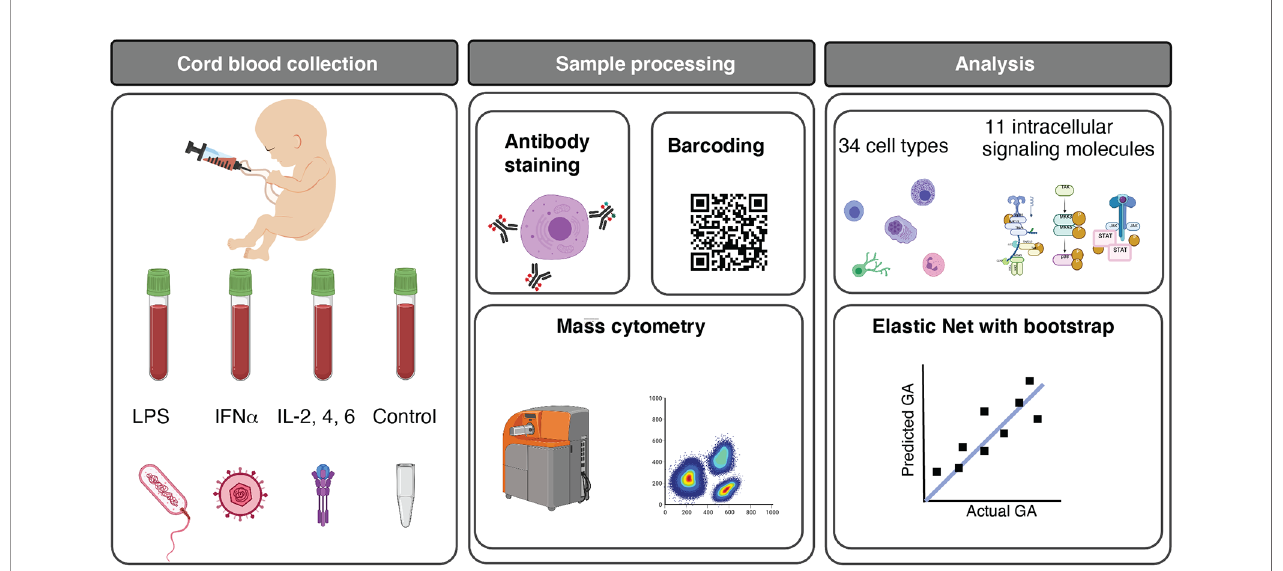
FIGURE 1 | Functional pro fi ling of the neonatal immune system across GA. Experimental and analytical work fl ow. 45 neonates ranging from 25w2d to 40w6d were studied. Umbilical cord blood was obtained immediately after birth, and whole blood was either left unstimulated (control) or stimulated for 15 minutes with LPS, IFN a , or a cocktail of interleukins (IL) (IL-2, IL-4, and IL-6). Immune cells were barcoded, stained with surface and intracellular antibodies, and analyzed with mass cytometry. The assay produced fi ve categories of immune features, providing information about cell frequency in 34 immune cell subsets, basal intracellular signaling activity (i.e. phosphorylation state) of 11 intracellular signaling proteins in these cells, and cell type-speci fi c signaling capacity in response to one of the three stimuli. 1,071 immune features were analyzed. Multivariate modeling using an Elastic Net method followed by a bootstrap procedure and unsupervised clustering of features were applied to characterize the GA-dependent progression of immune cell features. Image credits: Figure 1 was created in part on